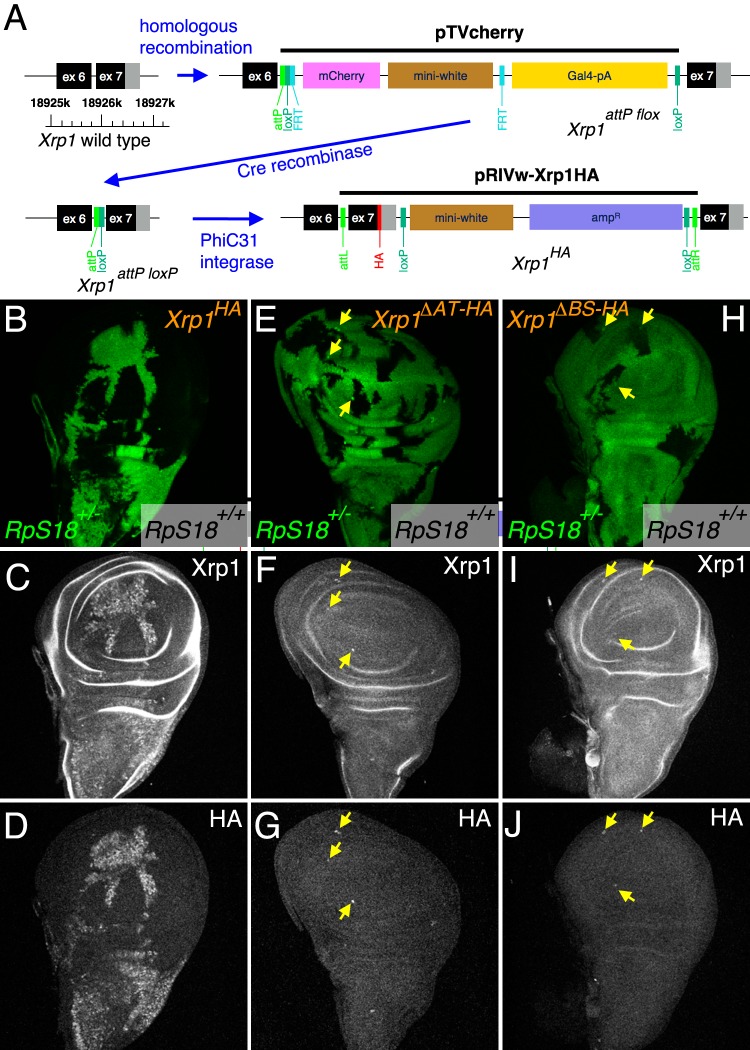
Modifications of the endogenous Xrp1 locus and their consequences for cell competition.(A) Sequential modifications of the Xrp1 locus in the 18925–18926 kb region of chromosome arm 3R by homologous recombination, Cre recombination and PhiC31 integration introduced modified and HA-tagged exon seven sequences into intron 6. (B–D) Cell competition in the homozygous Xrp1HA background. RpS18+/+ Xrp1HA/HA clones (unlabeled in B) grow to occupy most of the wing disc at the expense of RpS18+/-Xrp1 HA/HA cells (green in B), similar to what is seen in the Xrp1+/+ background (see Figure 3A and C). (C) Xrp1 protein is elevated in RpS18+/-Xrp1 HA/HA cells, as was seen for RpS18+/-Xrp1+/+ cells (see Figure 3B). (D) HA-tagged protein is detected only in the RpS18+/-Xrp1 HA/HA cells. (E–G) Cell competition in the homozygous Xrp1ΔΑT-ΗΑ background. RpS18+/+ Xrp1ΔΑT-ΗΑ/ΔΑT-ΗΑ clones (unlabeled in E) occupy less of the wing disc than RpS18+/-Xrp1ΔΑT-ΗΑ/ΔΑT-ΗΑ cells (green in E), similar to what is seen in the Xrp1-/- or irbp18-/- backgrounds (see Figure 1E). Note the survival of small clones of RpS18-/-Xrp1ΔΑT-ΗΑ/ΔΑT-ΗΑ (brighter green in E, eg arrows). Survival of Rp-/- genotypes is a feature of Xrp1 mutants. (F) Xrp1 protein is not elevated in RpS18+/-Xrp1ΔΑT-ΗΑ/ΔΑT-ΗΑ cells, but is in RpS18-/-Xrp1ΔΑT-ΗΑ/ΔΑT-ΗΑ (eg arrows). (G) As expected, the Xrp1 protein is HA-tagged (eg arrows). (H–J) Cell competition in the homozygous Xrp1ΔBR-HA background. RpS18+/-Xrp1ΔBR-HA/ΔBR-HA cells (green in H) are not out-grown by RpS18+/+ Xrp1ΔBR-HA/ΔBR-HA cells. Note the survival of small clones of RpS18-/-Xrp1ΔBR-HA/ΔBR-HA (brighter green in H, eg arrows), a feature of Xrp1 mutant genotypes. These RpS18-/-Xrp1ΔBR-HA/ΔBR-HA clones are the only cells where Xrp1 protein is elevated (eg arrows I) or HA-tag detected (eg arrows J). Genotypes B-D) w hs-FLP; FRT42D ubi-GFP M(2)56F/FRT42; Xrp1HA/Xrp1HA. E–G). w hs-FLP; FRT42D ubi-GFP M(2)56F/FRT42; Xrp1ΔAT-HA/Xrp1ΔAT-HA. H–J) w hs-FLP; FRT42D ubi-GFP M(2)56F/FRT42; Xrp1ΔBR-HA/Xrp1ΔBR-HA..